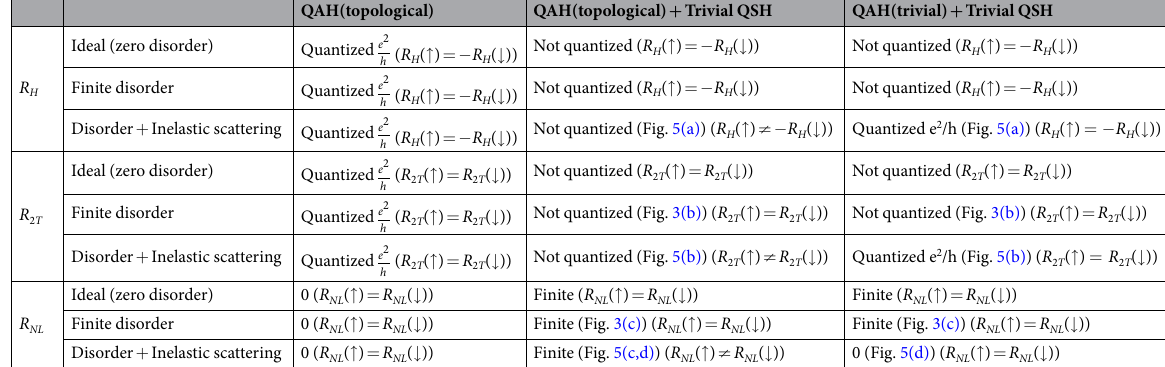
Table 1. Comparison of chiral(topological) QAH edge modes, chiral(topological) QAH edge mode with trivial QSH edge modes and chiral(trivial) QAH edge mode with trivial QSH edge modes. Note: In the 2T, 3T and 4T QAH samples depicted in Figs. 1,2, and 4 the magnetization direction is ( ↑ ) implying the QAH edge mode shown by black solid or dashed line is spin-up polarized. The conductance matrices depicted in Eqs. 2–6 and 14 as well as the calculations shown in Eqs. 7–13, 15–16 and the 2T, Hall and non-local resistances derived and plotted in Figs. 3, 5 are therefore for magnetization ( ↑ ). We follow similar procedure to calculate the resistances for magnetization direction ( ↓ ) in which case the QAH edge modes shown by black solid or dashed lines in Figs. 1, 2 and 4 will be spin-down polarized and mention the results in this table.